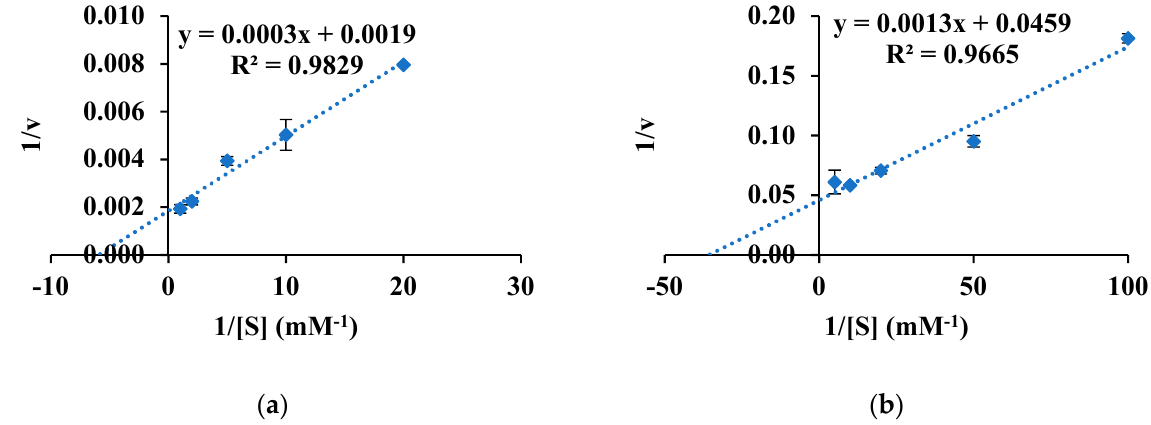
Figure 8. Lineweaver–Burk plots of Est8L ( a ) and Est13L ( b ) for pNPB. Five substrate concentrations were used; they were 0.05, 0.10, 0.20, 0.50, and 1.00 mM for Est8L, and 0.01, 0.02, 0.05, 0.10, and 0.20 mM for Est13L.